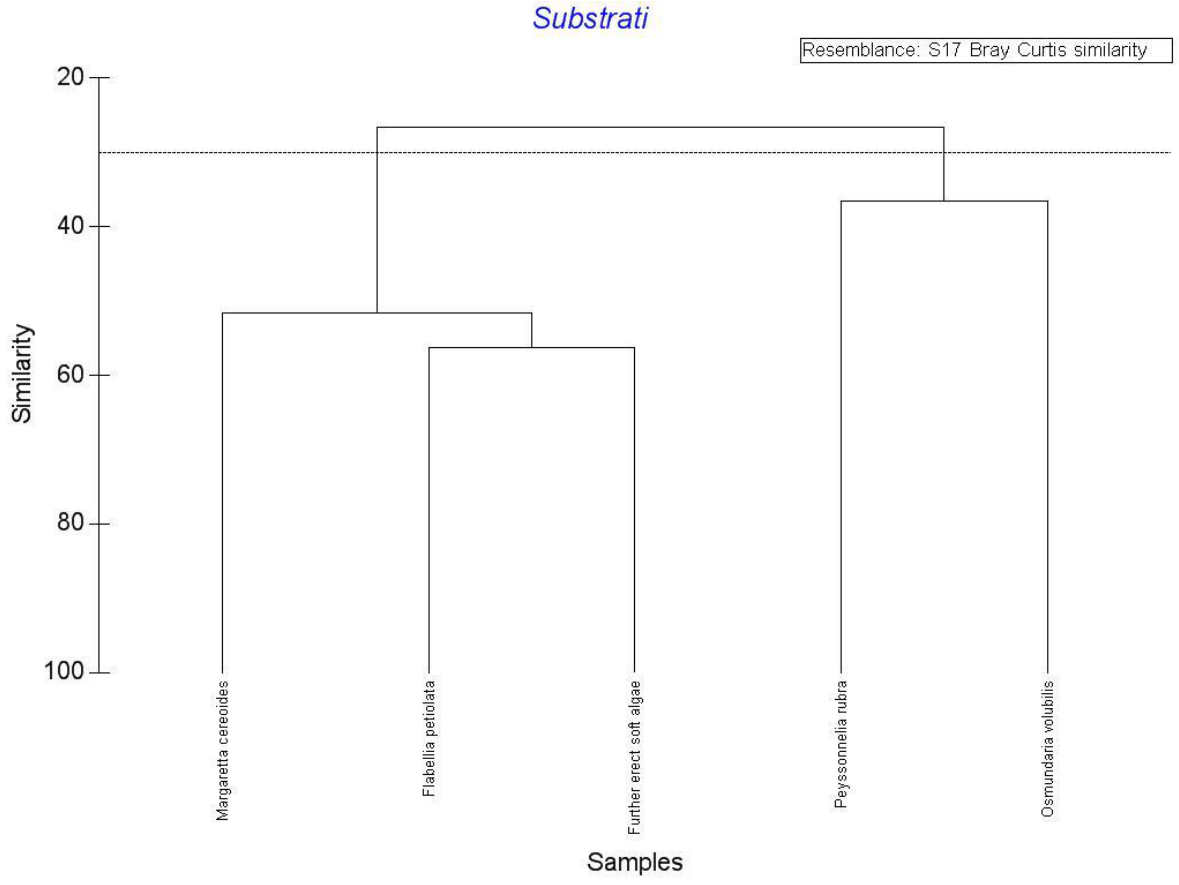
Figure 8. Bray–Curtis similarity dendrogram of substrates, treated as samples; two groups are defined at 30% BC level (hatched line).